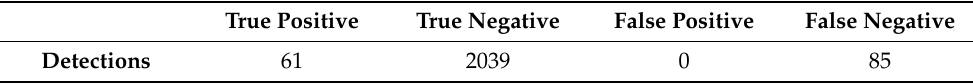
Table 2. Detection categories evaluating the automatic classification of howling bouts of the Guianan red howler monkey. True Positive True Negative False Positive False Negative Detections 61 2039 0